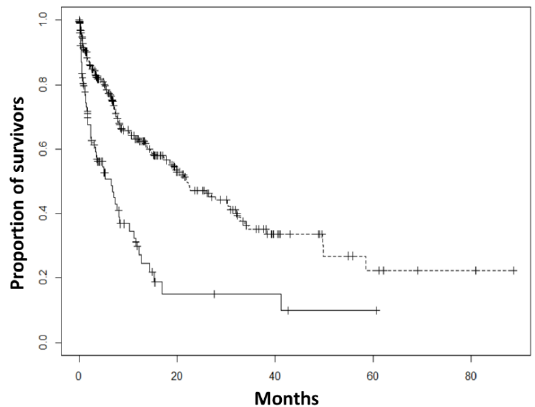
Figure 1. Overall survival according to TTF-1 status. Dash: TTF-1 positive carcinomas. Solid line: TTF-1 negative carcinomas.